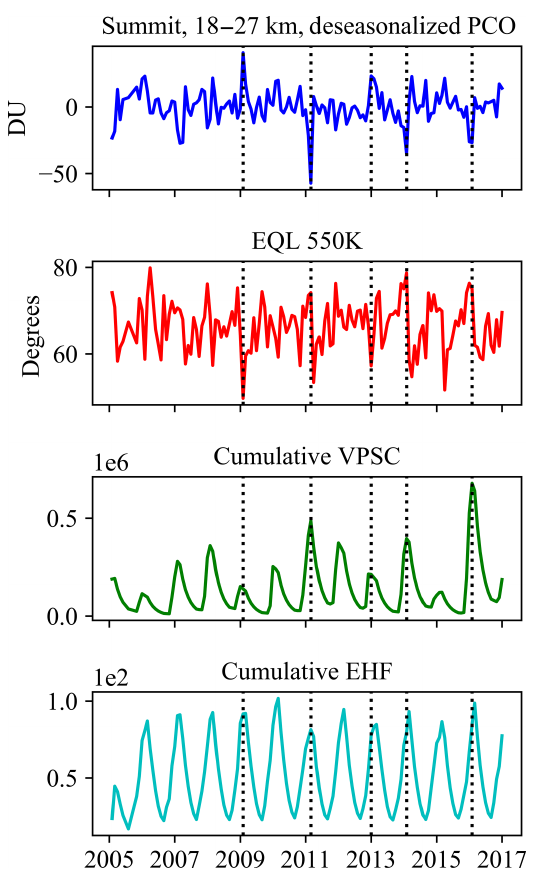
Figure 8. Coincidence of extreme events in deseasonalized ozone over Summit Station (18–27km; middle stratosphere) with the im- portant proxies from Table 4. The vertical black dashed line shows the time of the extreme values of the deseasonalized